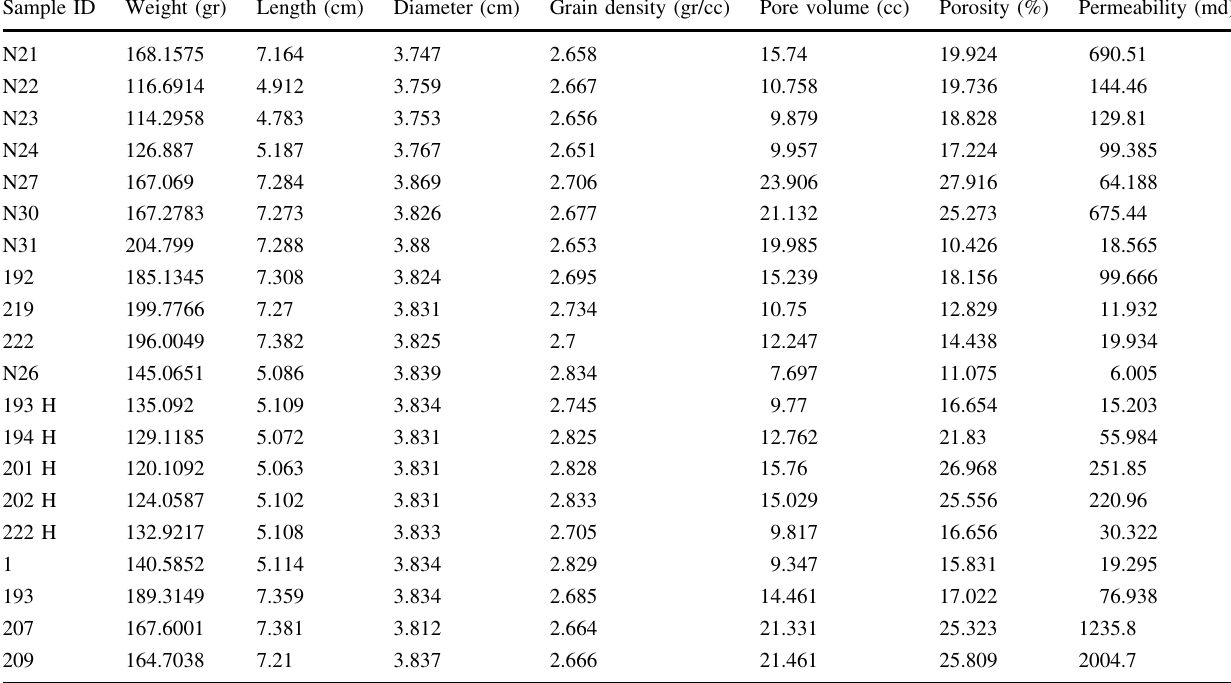
Table 1 Selected core samples characteristics Sample